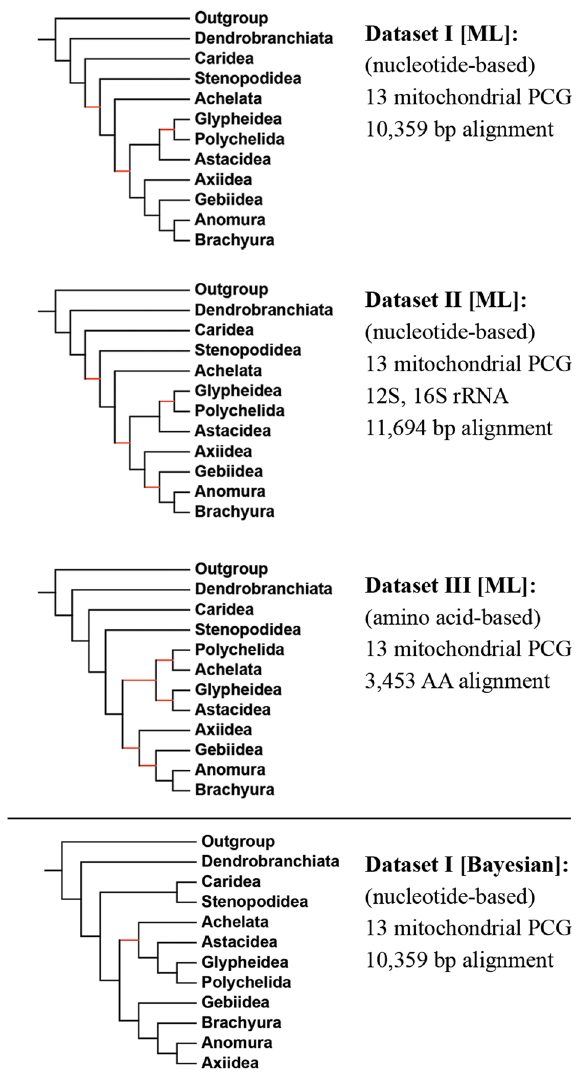
of < 95%, BI: posterior probabilities of <